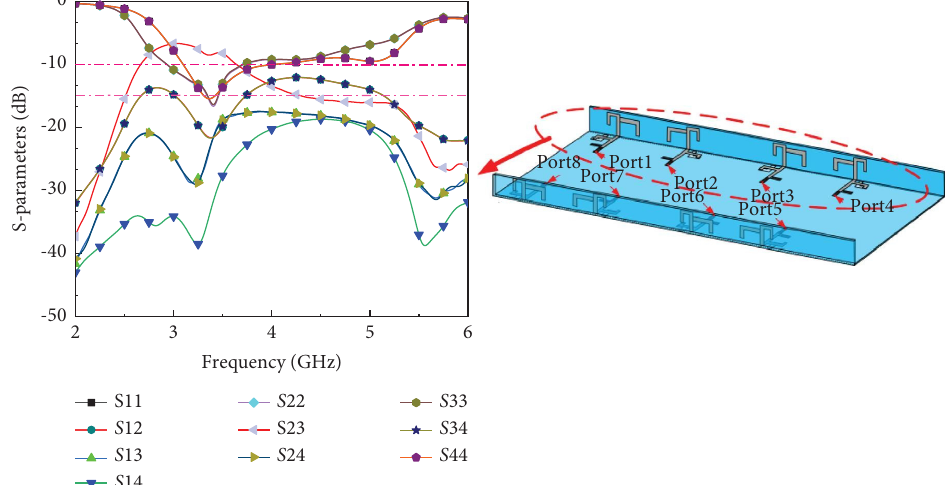
Figure 7: Geometry and S -parameter simulation of a centrosymmetric 8 × 8 MIMO antenna